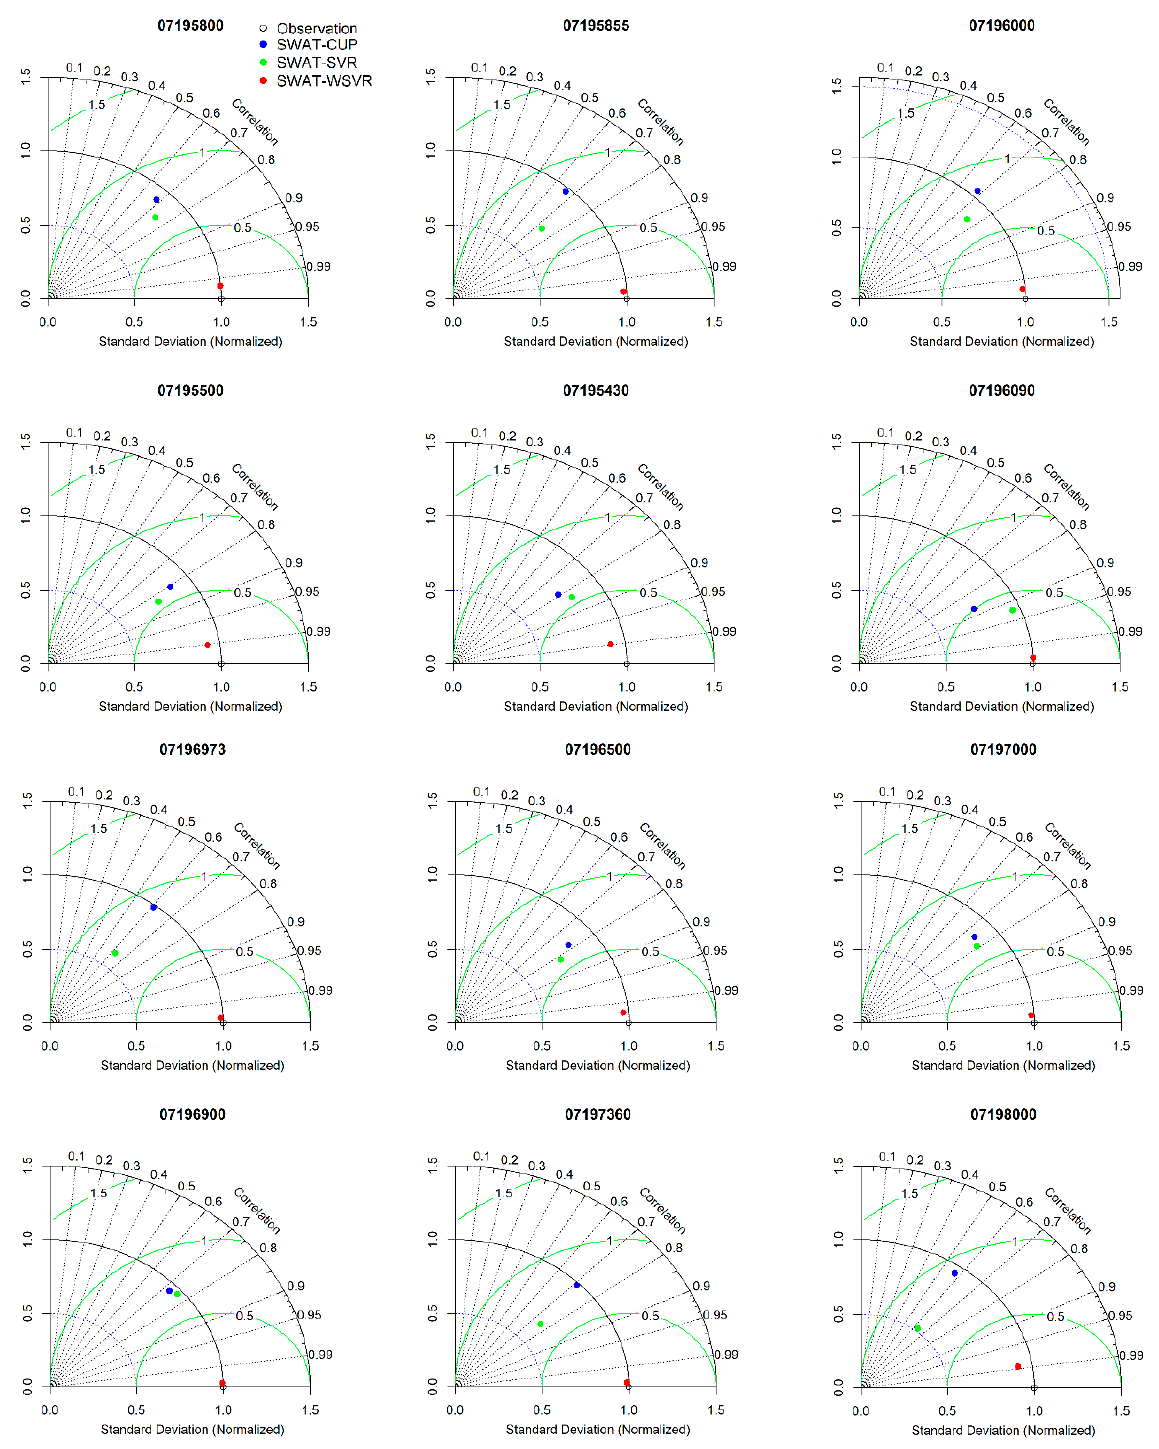
Figure 6. Taylor diagram of three models in comparison with the observation for each site.